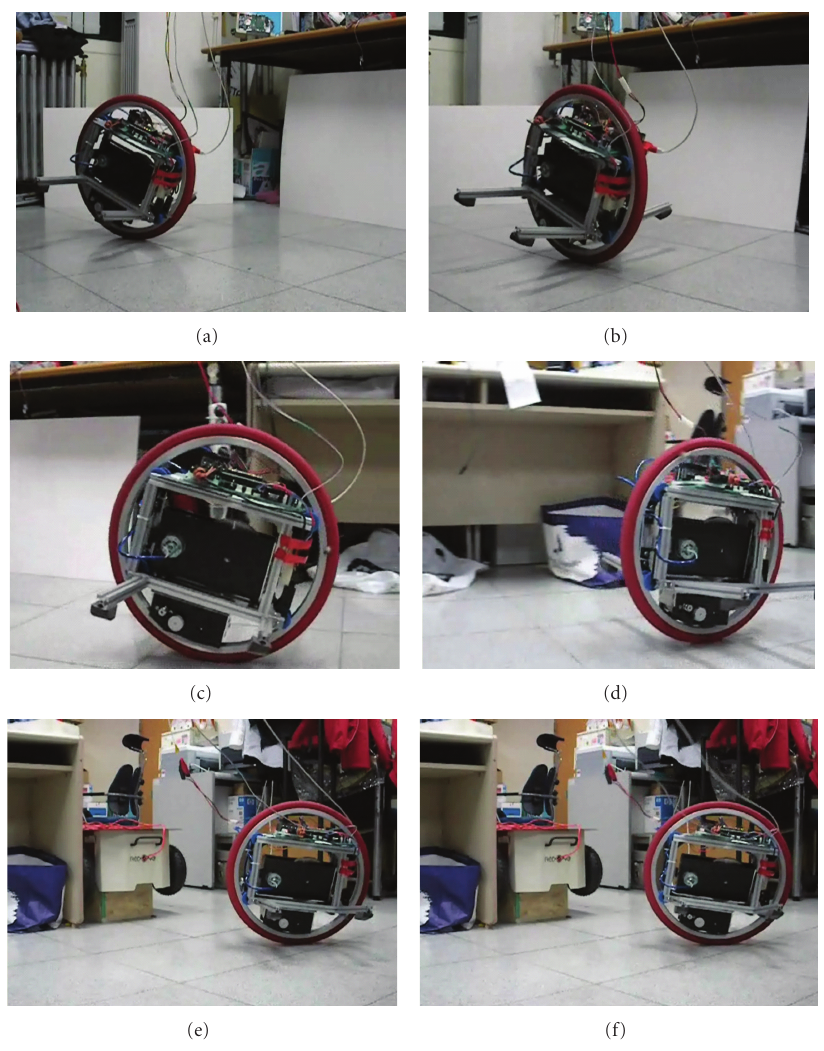
Figure 19: Neural network control: line